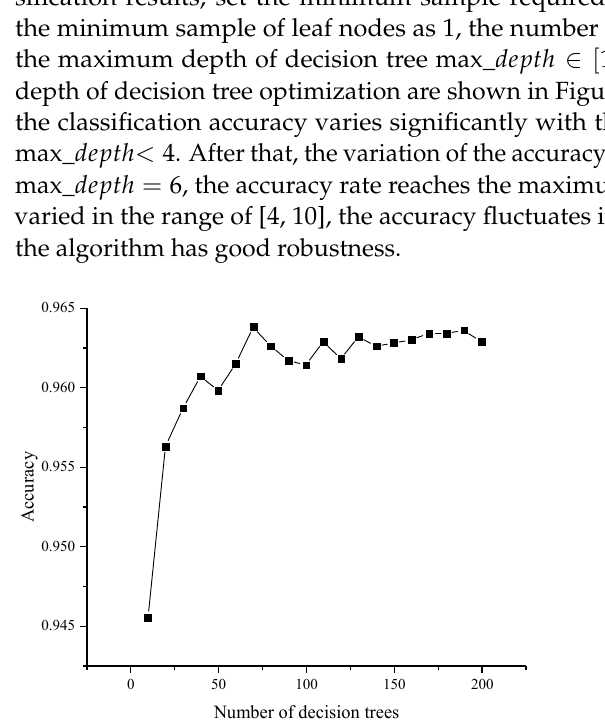
Figure 5. Optimization of the number of decision trees n _ estimators .